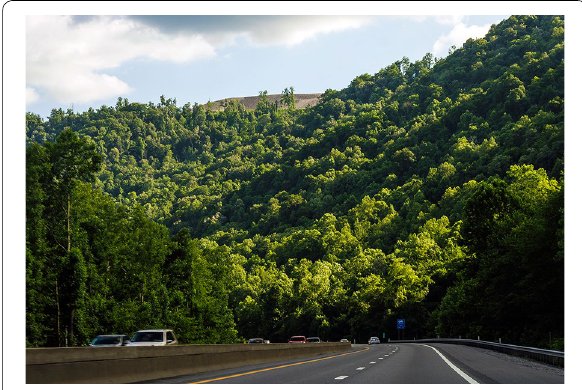
Fig. 9 In the background, view of an MTR site from the Interstate 64 southbound near Charleston, WV. Photo: Vincenzo